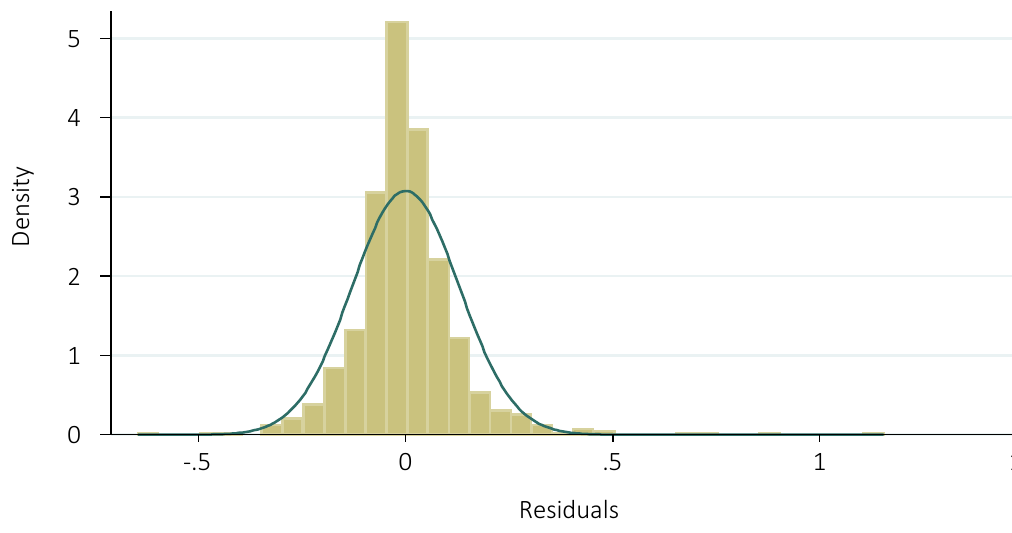
Figure 1. Distribution chart of